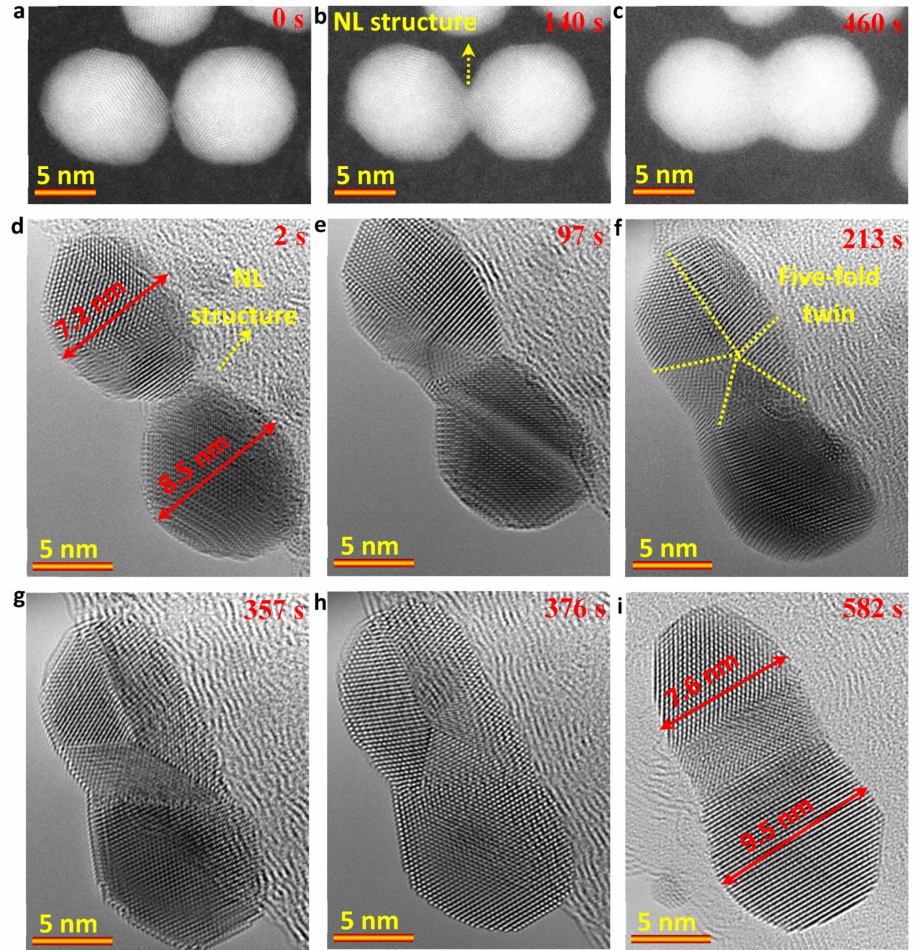
Figure 2. ( a – c ) Sequential HAADF-STEM images showing the growth of Au NRs with a length of ~20 nm from two Au NPs; ( d – i ) Sequential TEM images from Video S1 showing the growth of Au NRs with a length of ~18 nm at atomic scale by the attachment of two Au NPs. The electron dose rate is ~1.0 × 10 5 e/Å 2